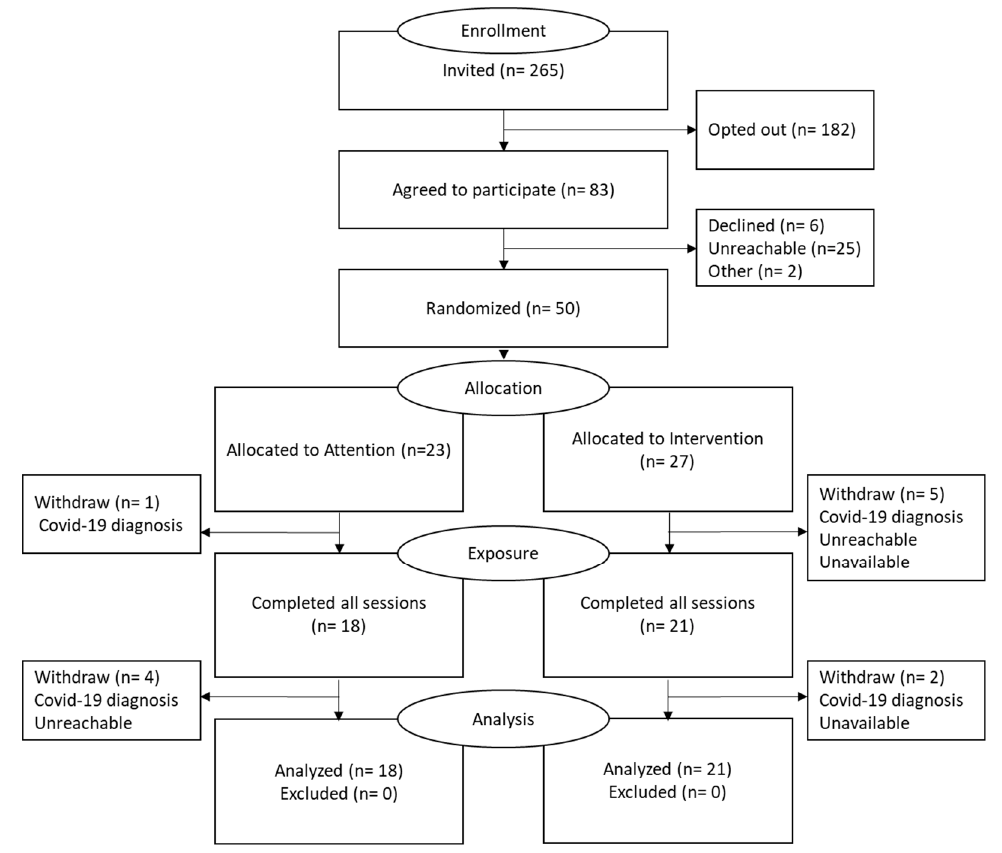
Figure 2. Study flow chart. Table 2. Sociodemographic data at baseline. Data compared using chi-square test except for age